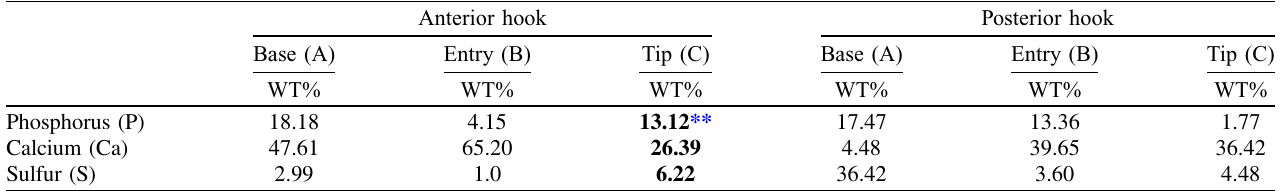
Table 7. Weight percent (WT%) for three major elements* in cross section cuts of the anterior hook and the posterior hook of Neoechinorhynchus ponticus n. sp.